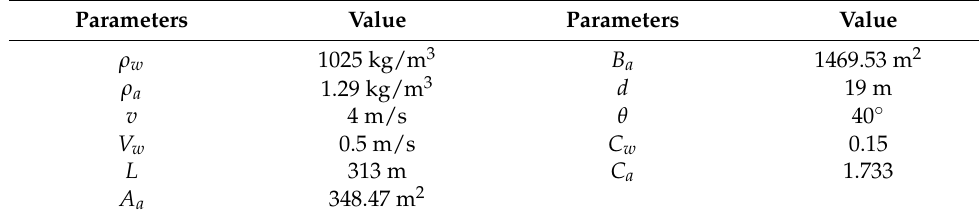
Table 2. The parameters of wind, water and ship [21,22].